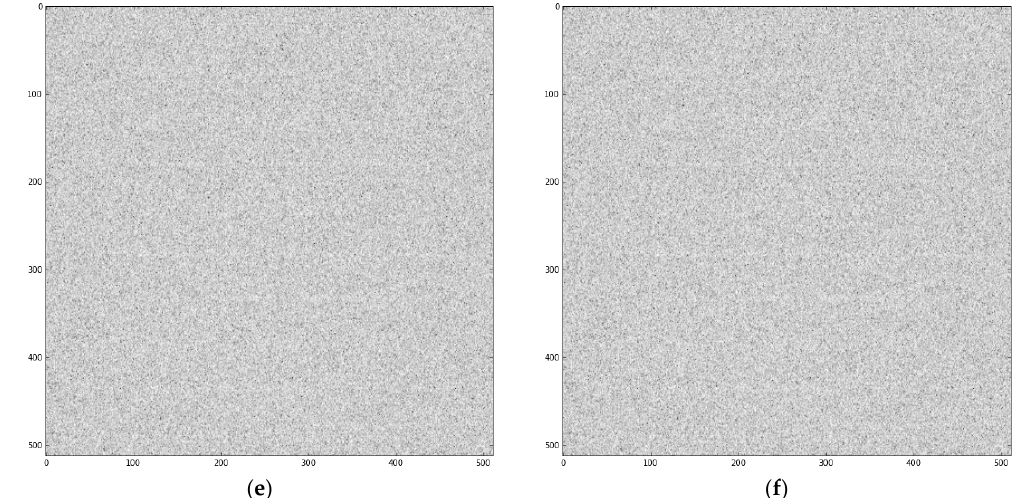
Figure 10. The SSD networks detection results. ( a ) ideal result 1; ( b ) ideal result 2; ( c ) not perfect result 1; ( d ) not perfect result 2; ( e ) no signal result 1; ( f ) no signal result 2.